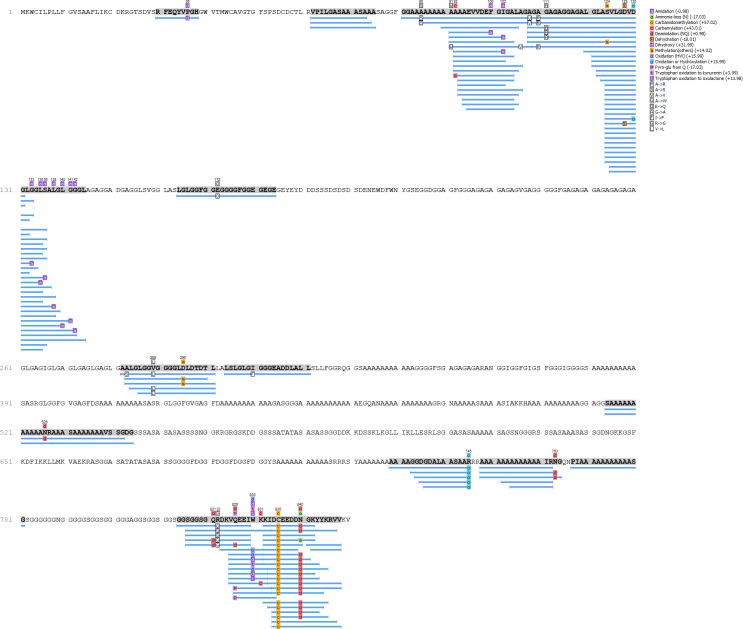
HavA - Hic74 coverage.